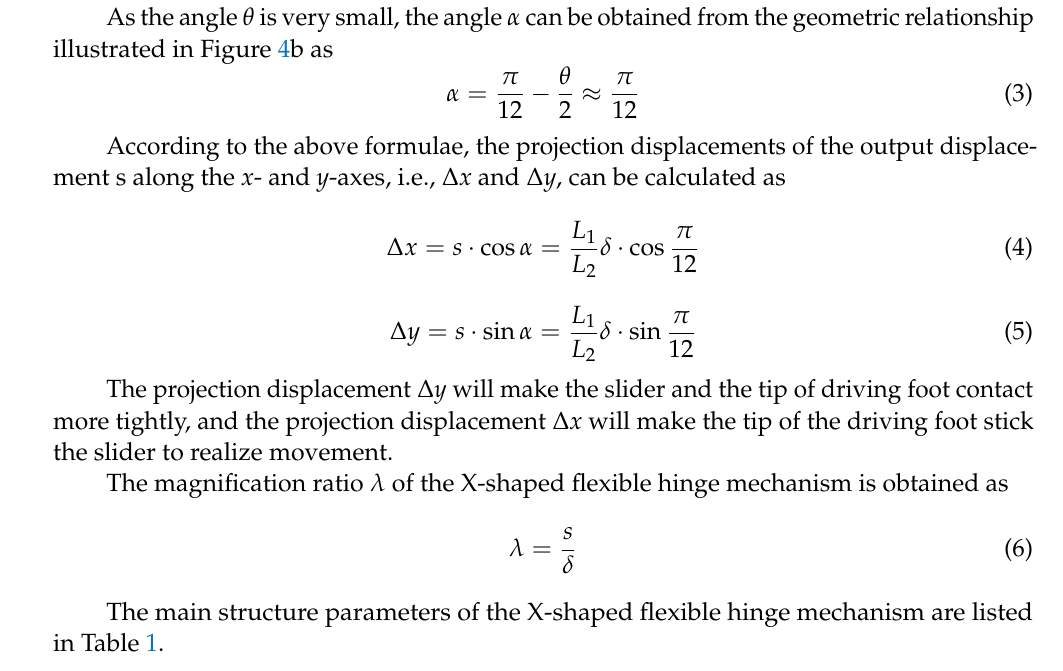
Table 1. The main structure parameters of the X-shaped flexible hinge mechanism. Parameter Value